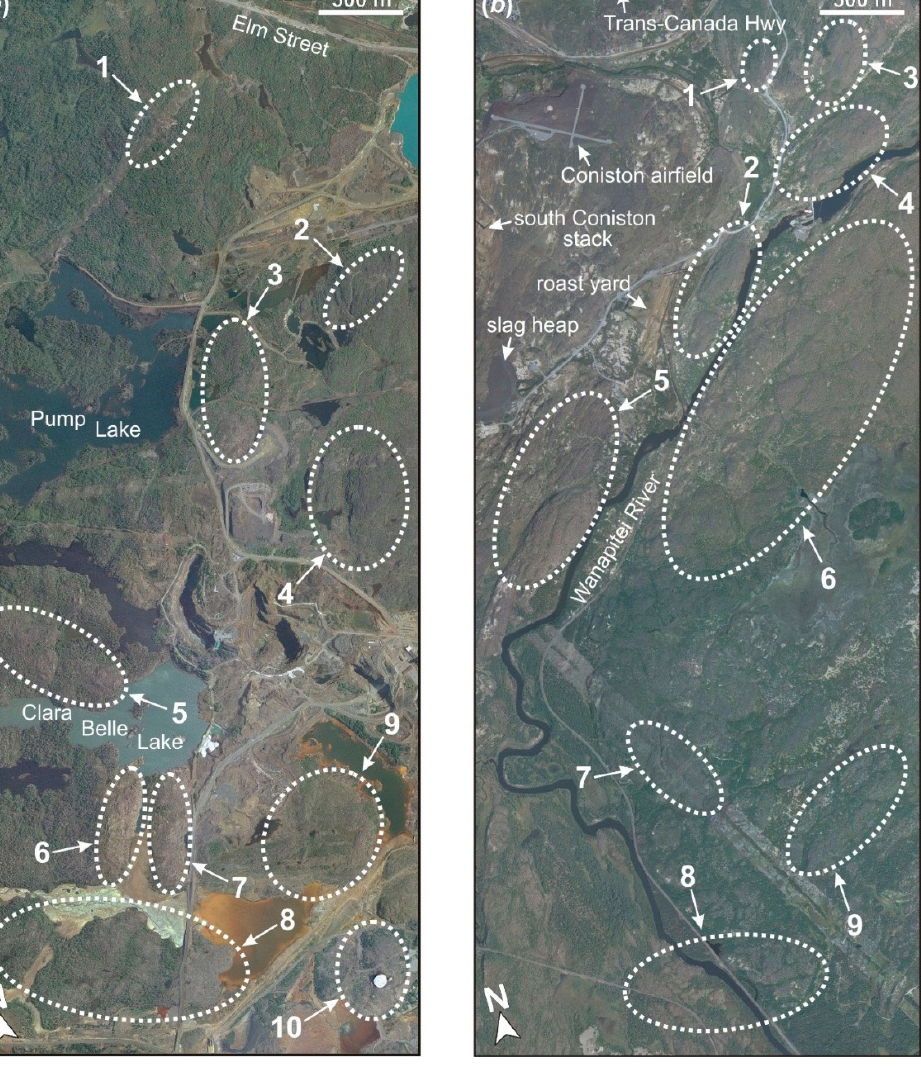
Figure 7. These true-color aerial orthophotos depict selected examples of prominent exposures of coated bedrock (inside dotted ovals) for key parts of the Copper Cliff ( a ) and Coniston ( b ) study areas. Depicted areas are outlined in Figure 6. The four Coniston sites depicted in Figure 2 are present in (b) at the south Coniston stack (Figure 2a), Site 2 (Figure 2b), Site 1 (Figure 2c), and the Trans-Canada Highway (Figure 2d).